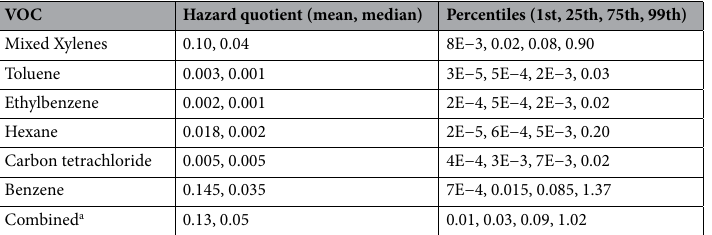
VOC Hazard quotient (mean, median) Percentiles (1st, 25th, 75th, 99th)